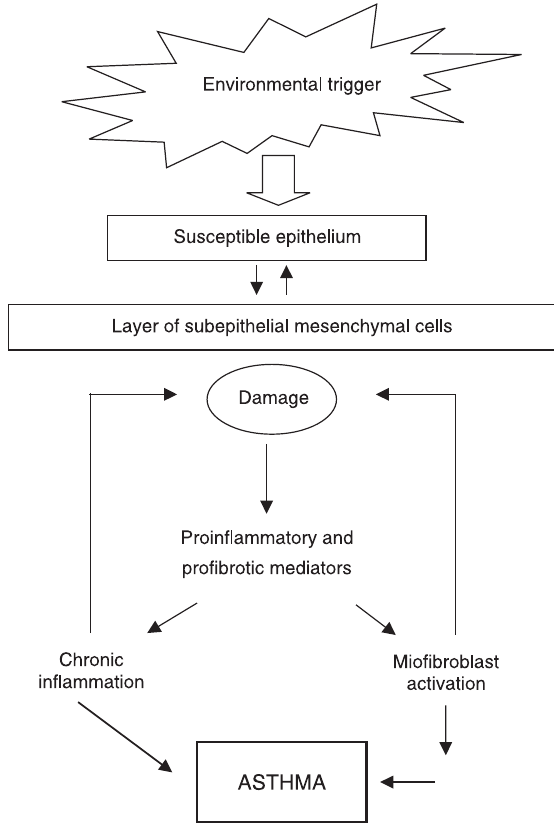
Figure 2. Epithelial-mesenchymal communication in asthmatic airways. The susceptible epithelium can release proinflamma- tory and profibrotic mediators that mediate remodeling and per- petuate the chronic inflammatory cycle. It is postulated that remodeling and inflammation attenuate the normal repair of damaged epithelium, leading to the development of